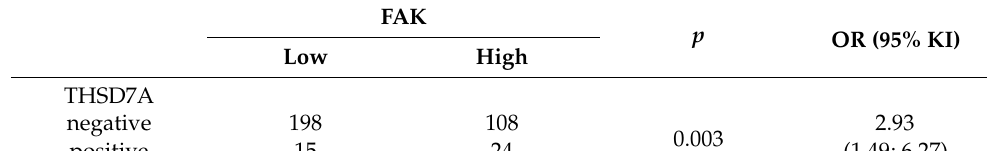
Figure 2. FAK shows cytoplasmic staining pattern; ( a ) tumor cells with high FAK expression; ( b ) Table 3. Association between FAK expression and THSD7A expression. tumor cells with low FAK expression with a magnification of 100×. FAK p OR (95% KI) Low